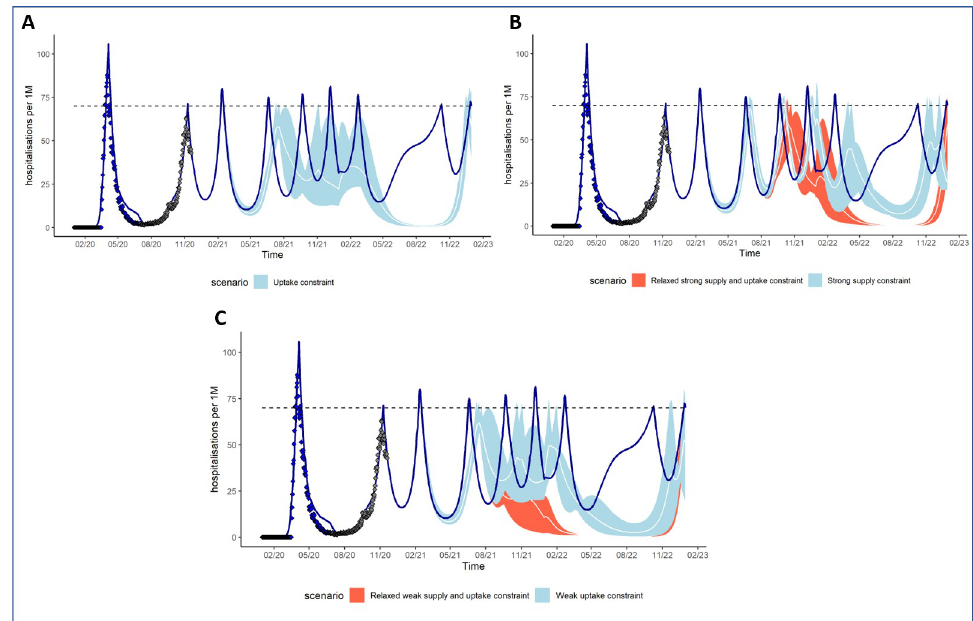
Fig 3. Daily hospitalization incidence (rate per million population per day) with and without an immunisation program with varying uptake and supply constraints, 2020–2022. Based on reference scenario for disease characteristics, NPI response (second wave threshold), vaccine profile (protection against infection) and NPIs maintained until end of 2022. Panel A –No vaccination (dark blue curve) and vaccination scenario under uptake constraint (light blue), Panel B –No vaccination (dark blue curve) and vaccination scenarios with strong supply constraint under two assumptions for relaxation of such constraints: the constraints not being eased during the second half of the year (light blue) or the constraints being eased during the second half of the years (orange), Panel C –No vaccination (dark blue curve) and vaccination scenarios with weak supply constraint under two assumptions for relaxation of such constraints: the constraints not being eased during the second half of the year (light blue) or the constraints being eased during the second half of the years (orange). The variation in impact due to the range of vaccine efficacy considered is shown as the area of the vaccine impact